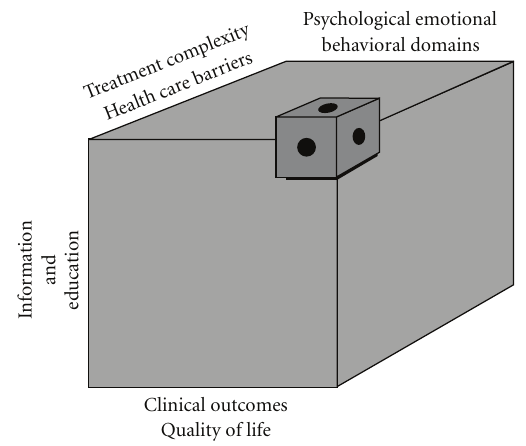
Figure 1: Long-term oxygen therapy: a research agenda for com-